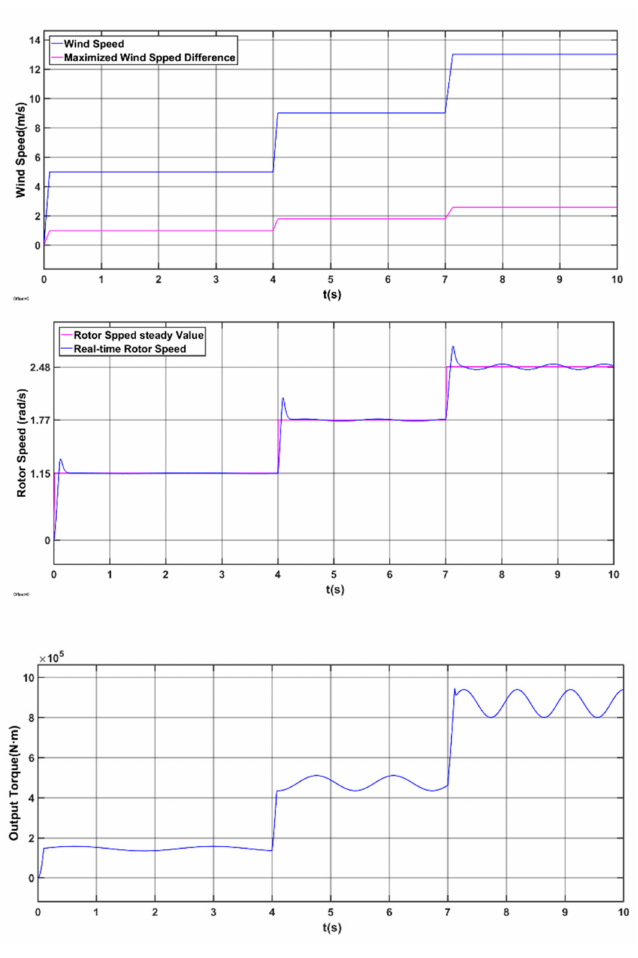
Figure 8. Ripple status of PMSG under wind shear.